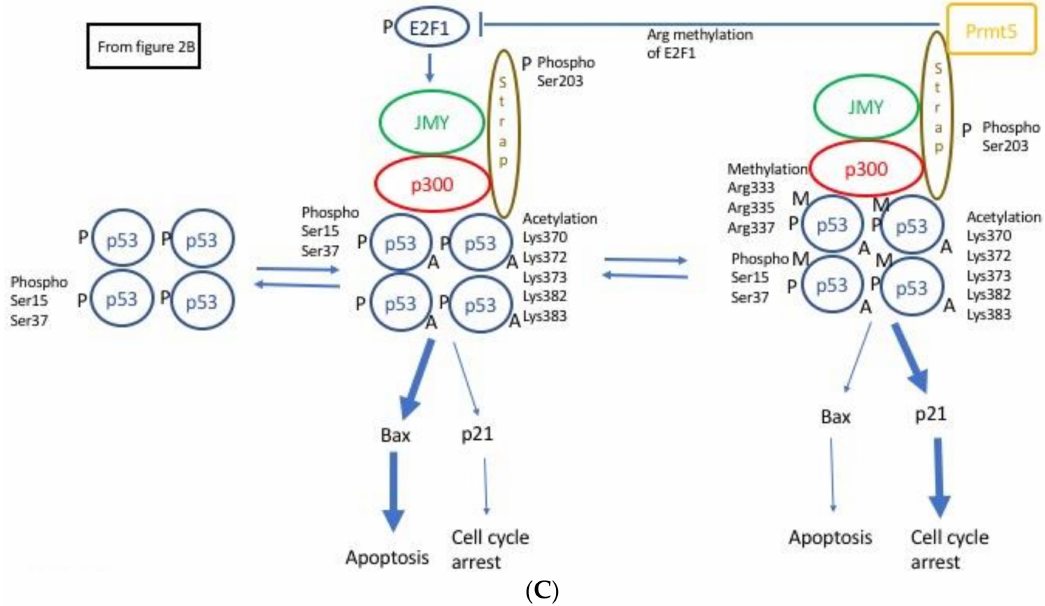
Figure 2. JMY (Junctional Mediating and Regulating Y protein)/P53 interaction pathway. ( A ) JMY’s regulation. In unperturbed cells, JMY levels are maintained at a constant state by a balance